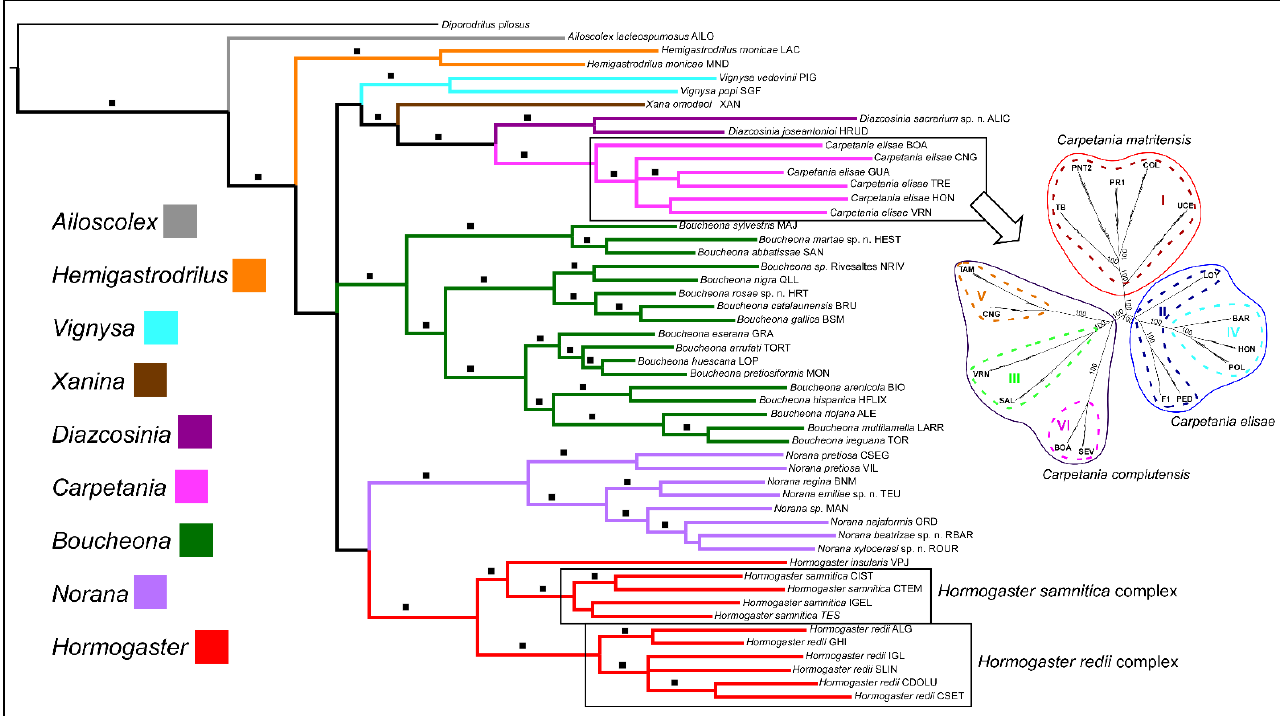
Figure 3. Modified from [66,69]. Bayesian inference of the phylogenetic relationships of Hormogastridae based on a combined morphological and molecular matrix (concatenated sequence of COI-16S-tRNAs-28S-H3 markers). The inset shows the species delimitation of the Carpetania elisae complex based on a maximum likelihood analysis of the SNP dataset obtained with GBS (modified from [39,40]).